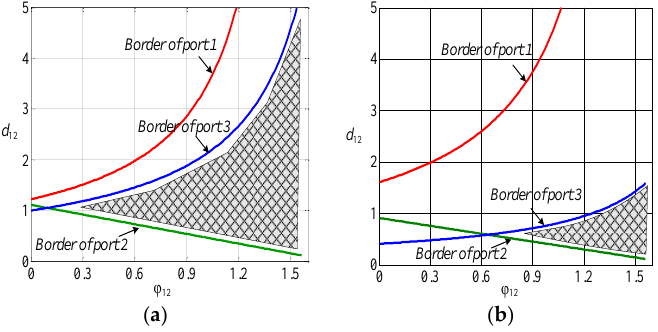
Figure 7. Soft-switching regions for TPI bidirectional DC/DC converter. ( a ) φ 13 = π /9, d 13 = 1; ( b ) φ 13 = π /6, d 13 = 0.6.